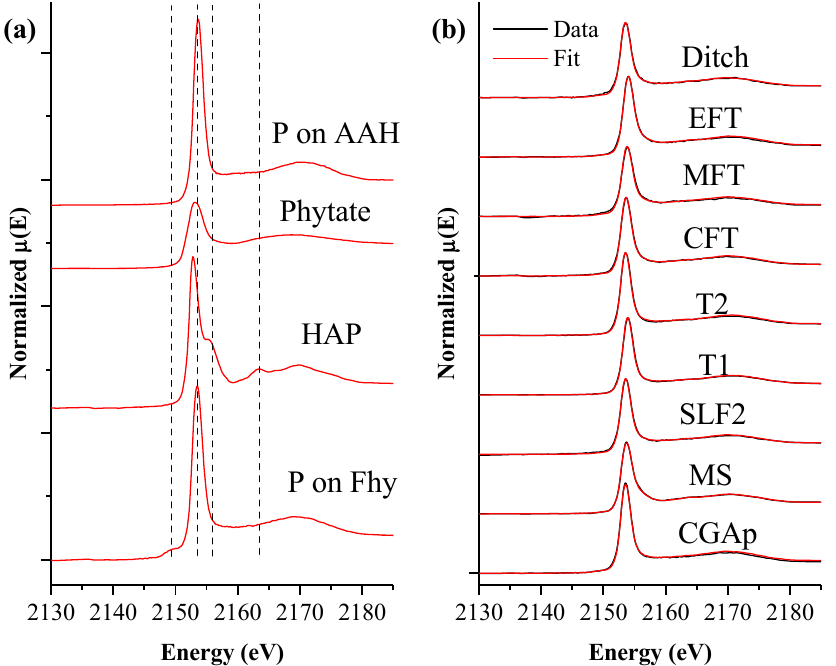
Figure 4. Phosphorus (P) reference spectra used for linear combination fittings (LCF) ( a ) and P X-ray absorption near-edge structure (XANES) spectra and their linear combination fits for the soils ( b ). Standards are P adsorbed onto amorphous aluminum hydroxides (P on AAH), phytic acid (phytate), hydroxyapatite (HAP), and P adsorbed onto ferrihydrite (P on Fhy). CGAp is a community garden soil; MS had a manure storage shed on it; SLF2 is an agricultural field on the same farm as MS; T1 and T2 are agricultural fields from a second farm; and CFT (center field transect), MFT (middle field transect), EFT (edge field transect), and Ditch are agricultural soil samples from a third farm along a transect.